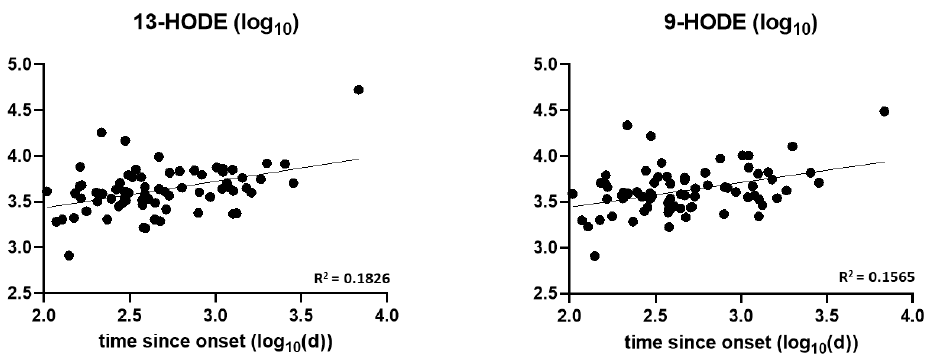
Figure 2. Correlation plot between LA metabolites and disease duration in ALS patients. Pearson correlation tests and p -value adjustment (Benjamini-Hochberg) were performed for all detected oxylipins and clinical parameters. A positive correlation was found for 13-HODE and 9-HODE with time since onset (logarithmic transformation).